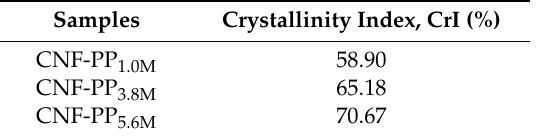
Table 3. XRD analysis data of CNF-PP 1.0M , CNF-PP 3.8M and CNF-PP 5.6M .